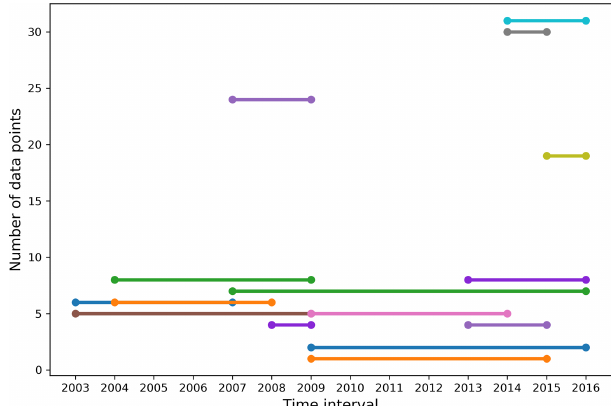
Figure 8. Number of comparable data points in the top 100m of the water column, obtained from measurements made at the same station and within set depth intervals (of 3.5m at the surface, in- creasing progressively to 15m to a depth of 100m), between each year of the dataset.